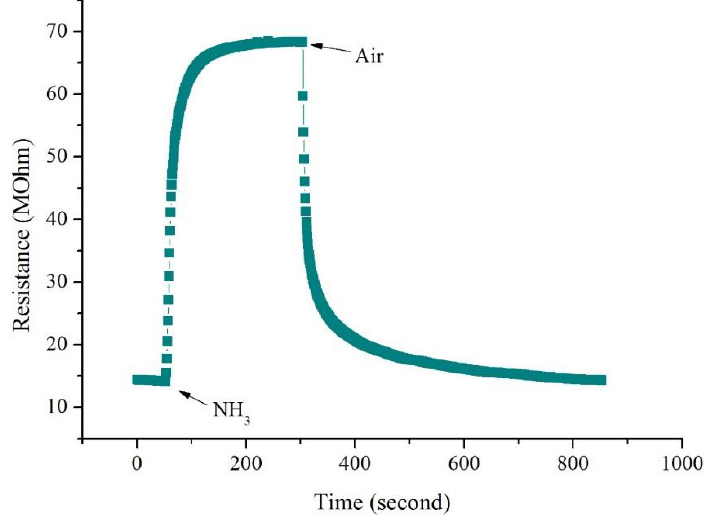
Figure 6. Changes in resistance of the CSA-doped PA6/PANI composite nanofibers with respect to time on the exposure of NH 3